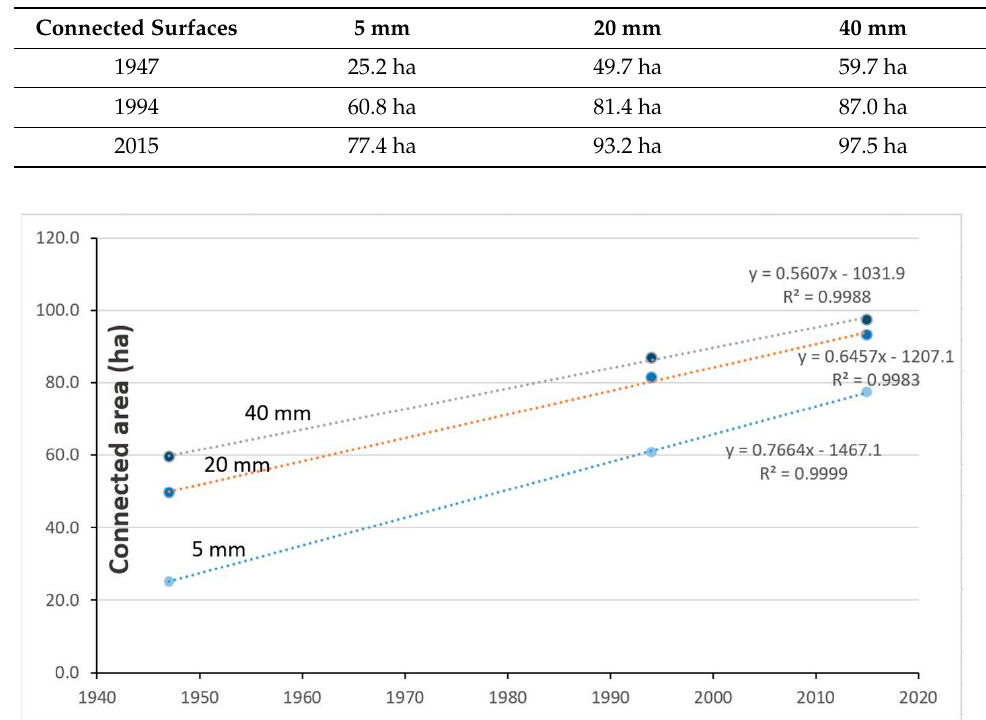
Figure 11. Evolution of connected areas.